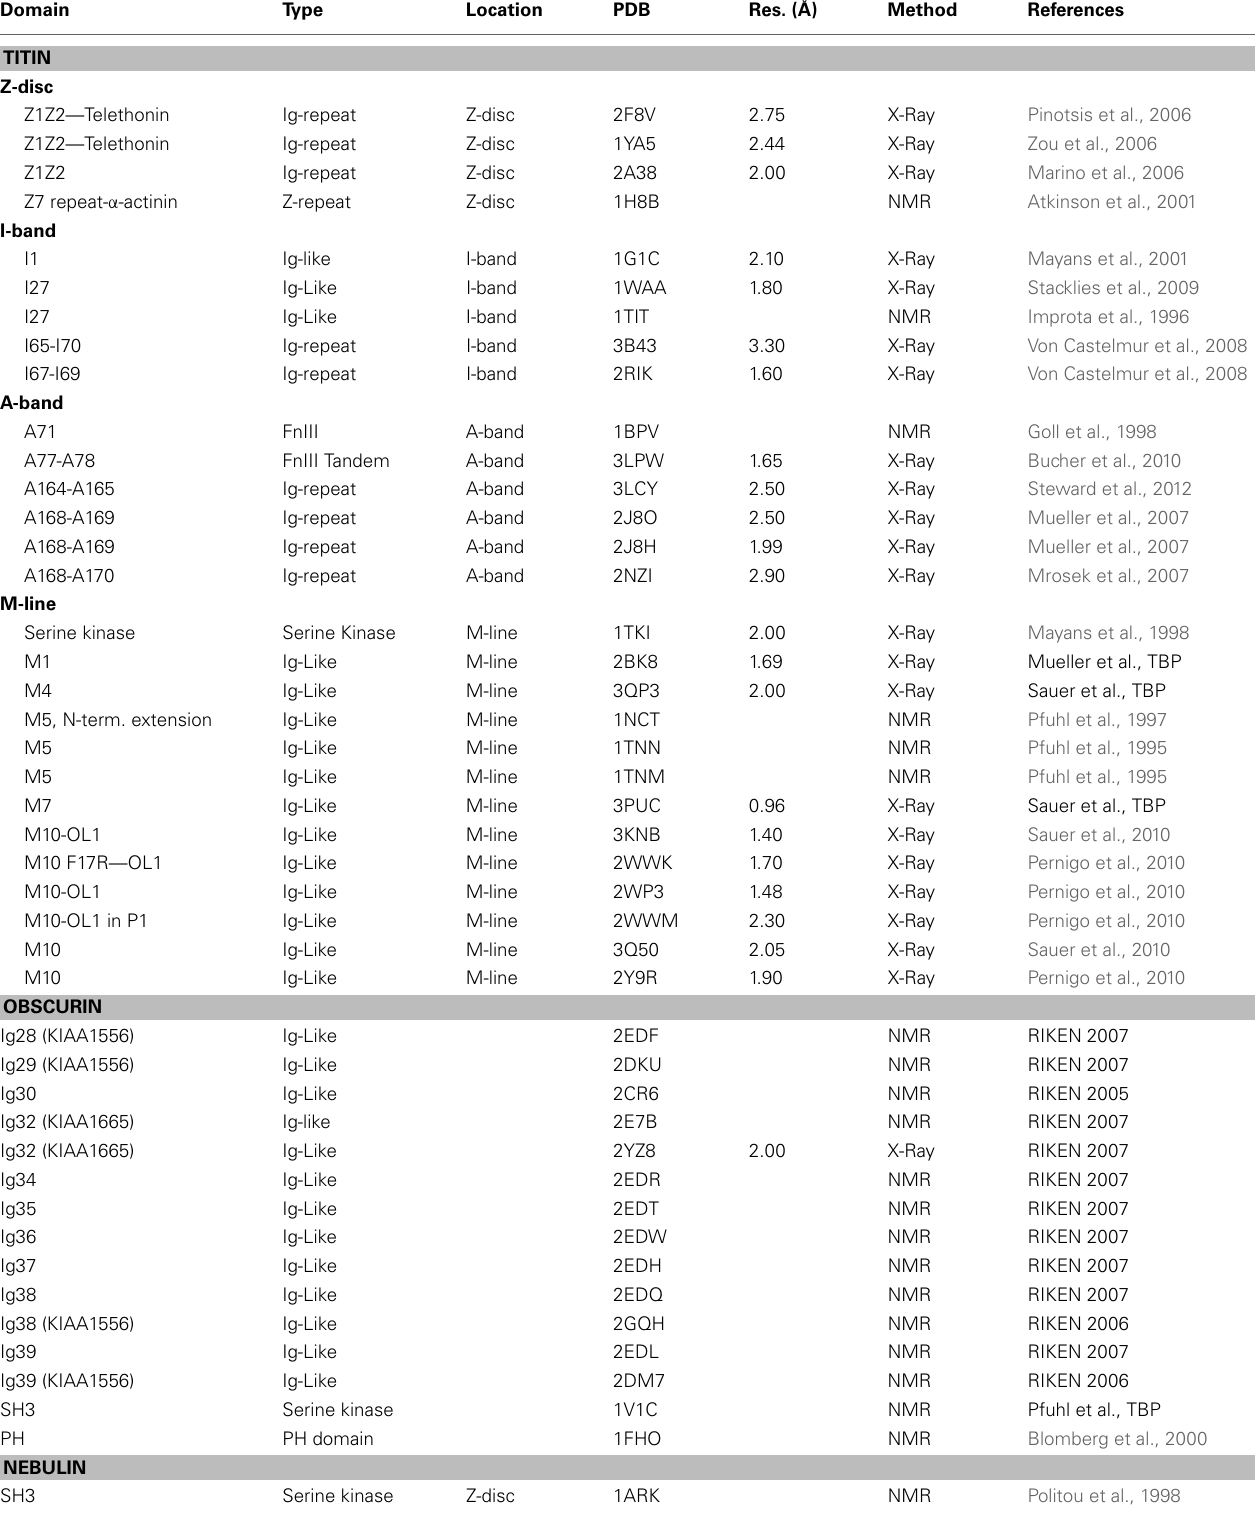
Table 1 | Domain structures of titin, obscurin, and